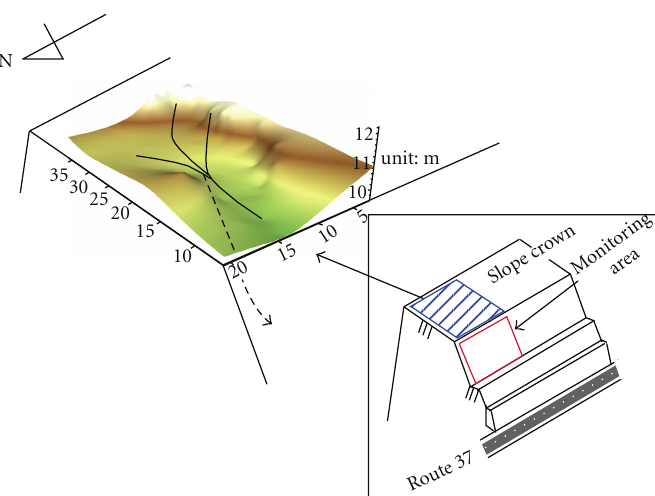
Figure 7: Topography of the crown of slope based on surveying.